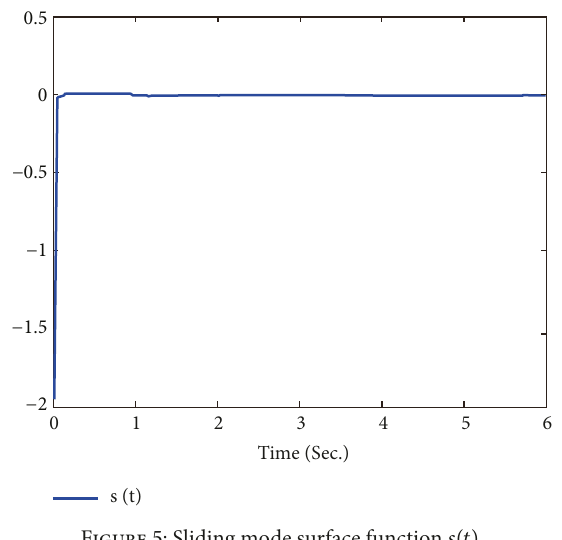
Figure 5: Sliding mode surface function 𝑠(𝑡)